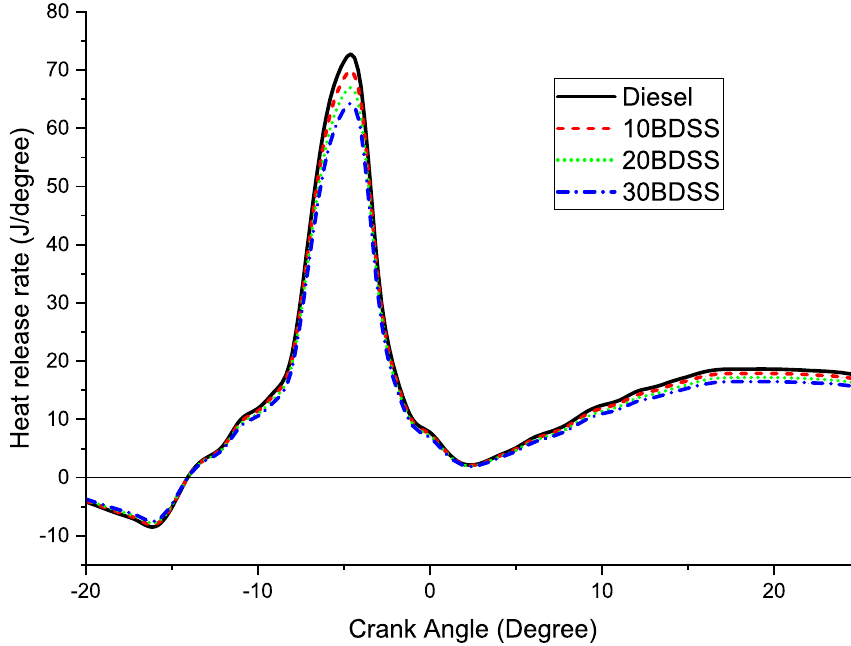
Figure 4. Influence of biodiesel blends in heat release